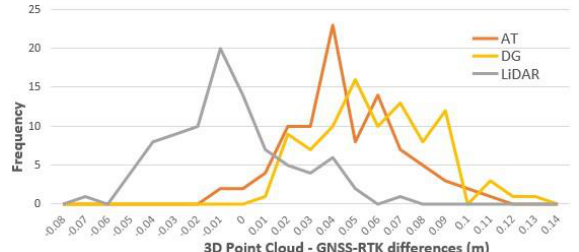
Figure 8: Histogram analysis of the height differences between the AT (orange), DG (yellow) and LiDAR (grey) 3D point clouds against the GNSS-RTK CPs.